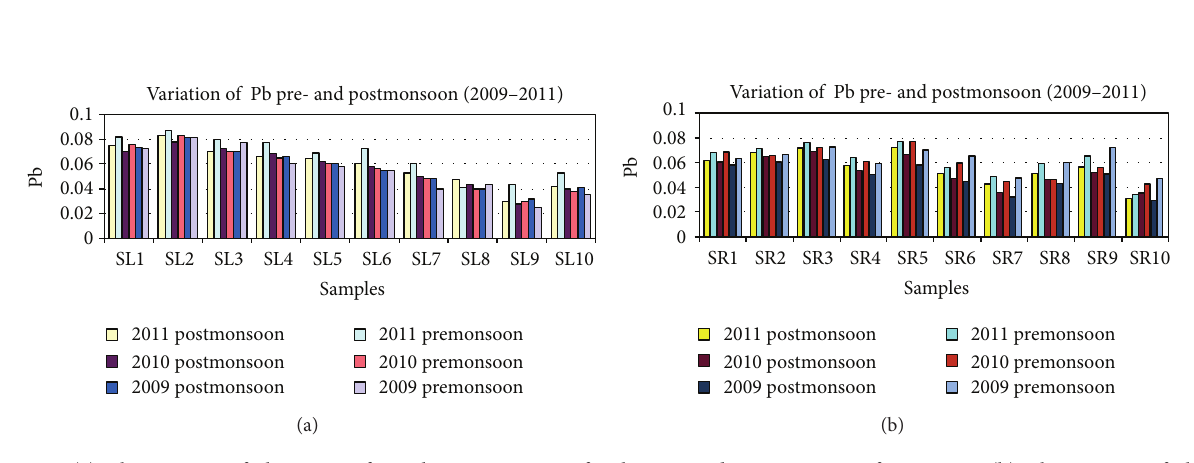
Figure 8: (a) Observations of Pb in water from the sites SL1–SL10 for the pre- and postmonsoon of 2009–2011. (b) Observations of Pb in water from the sites SR1–SR10 for the pre- and postmonsoon of